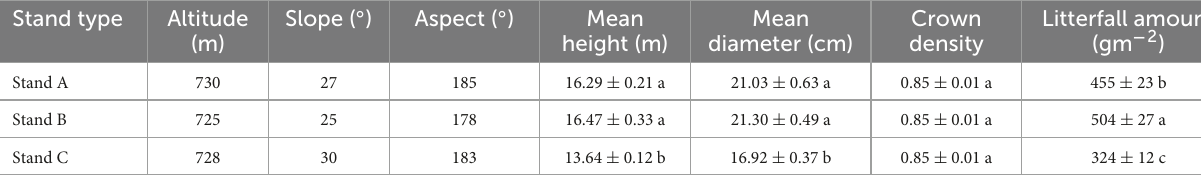
Data indicate the average of five replicates ± standard deviations. Stand A indicates a mixed plantation of Chinese fir and Mytilaria laosensis . Stand B indicates a mixed plantation of Chinese firand Micheliamacclurei .StandCindicatespureplantationofChinesefir.Variouslowercaselettersindicatesignificantdifferencesamongthedifferentstandtypesat P <